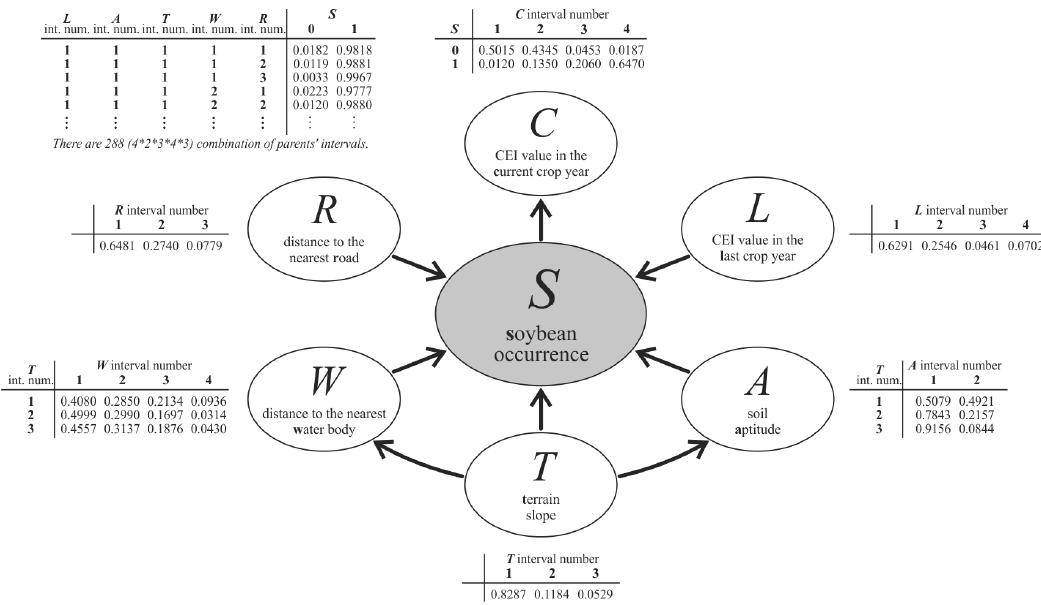
Figure 8. Bayesian network structure and the defined probability function (shown in the related table) for each variable used in this study case. The six context variables are described in Table 1 and the interval numbers are detailed in Table